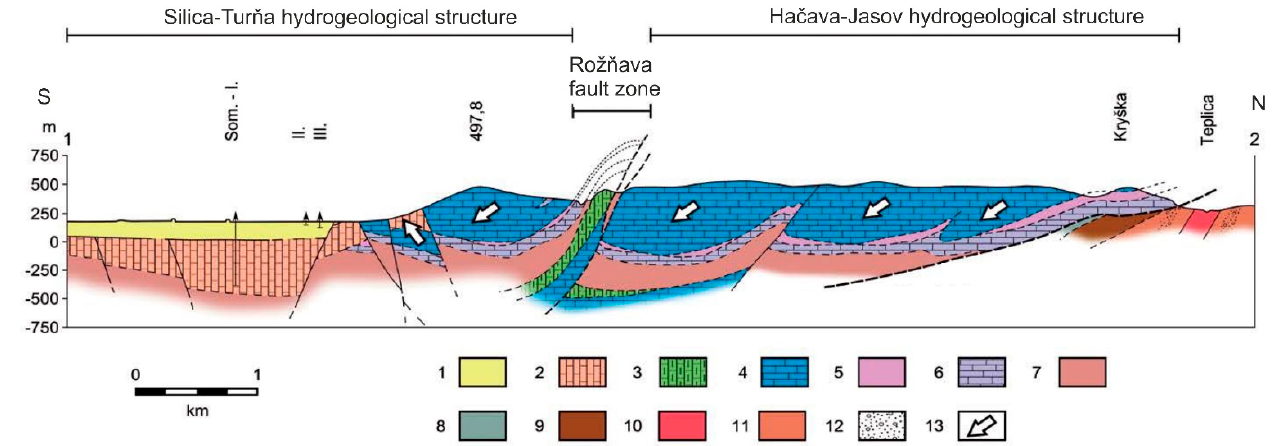
Figure 2. Geological profile of the Jasov Plateau, Reprinted with permission from ref. [47] . Copyright 2012, Zacharov. Profile: Tertiary: 1—clastic sediments, carbonaceous clays, lignite (Miocene); 2—limestone, shales, conglomerates, Šomody formation (Eocene—Oligocene); Mesozoic: 3—limestones, marls, breccias undistinguished (Upper Triassic–Jurassic); 4— Waxeneck, Wetterstein and Steinalm limestones (Middle–Upper Triassic); 4—Gutenstein dolomites (Upper Triassic); 6— Gutenstein limestones (Upper Triassic); 7—shales, sandstones (Lower Triassic); 8—phyllites, crystalline limestones (Tri- assic–Jurassic); Paleozoic: 9—metamorphosed sandstones (Permian); 10—metarhyolites (Permian); 11—phyllites (Per- mian); 12—metaconglomerates (Permian); 13—direction of ground water flow.